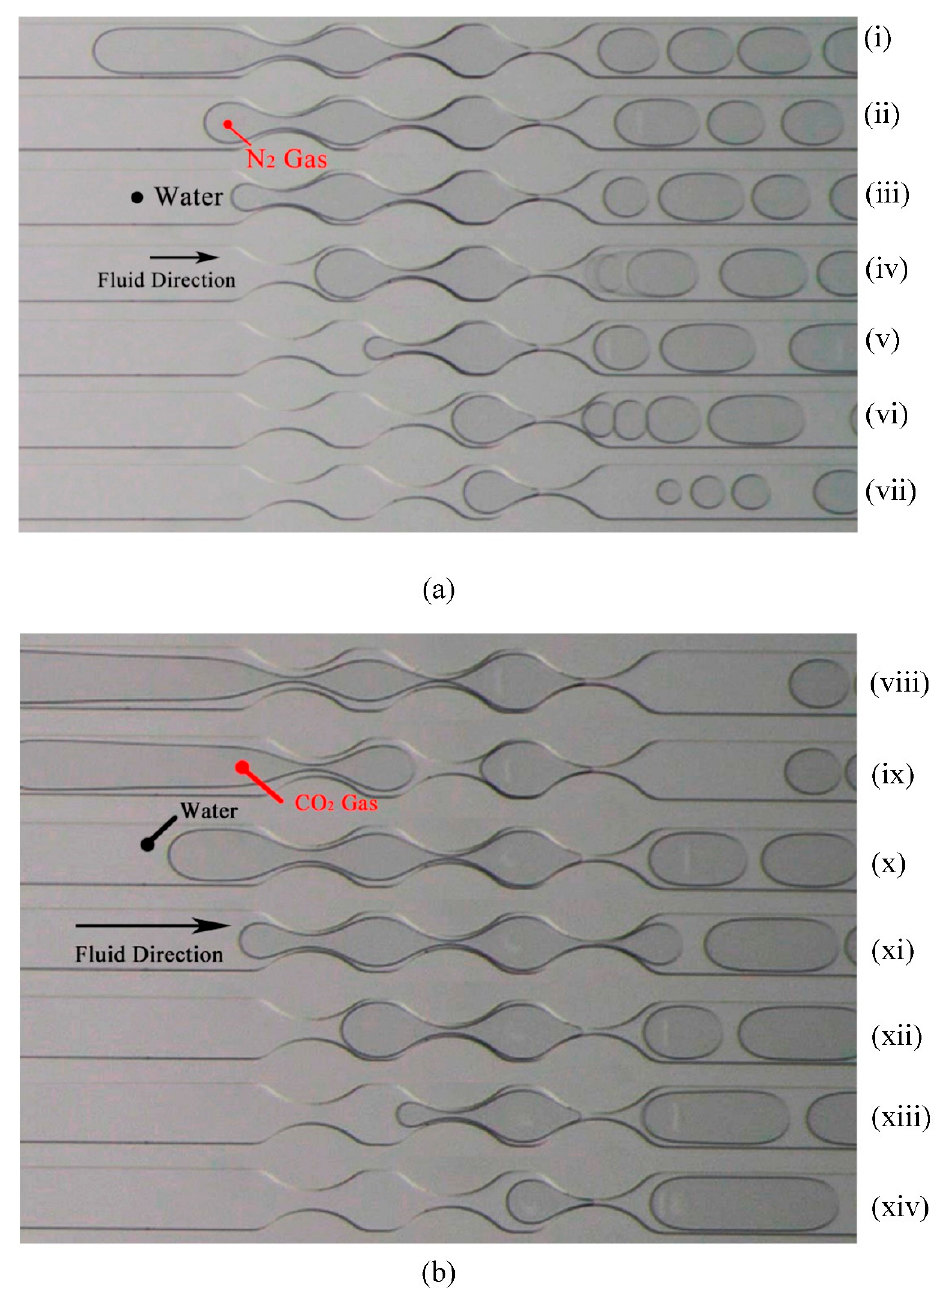
Figure 8. Gas Snap-Off in Continuously Tapering Pore Throat: ( a ) Nitrogen Gas Group; ( b ) Carbon Dioxide Gas Group.